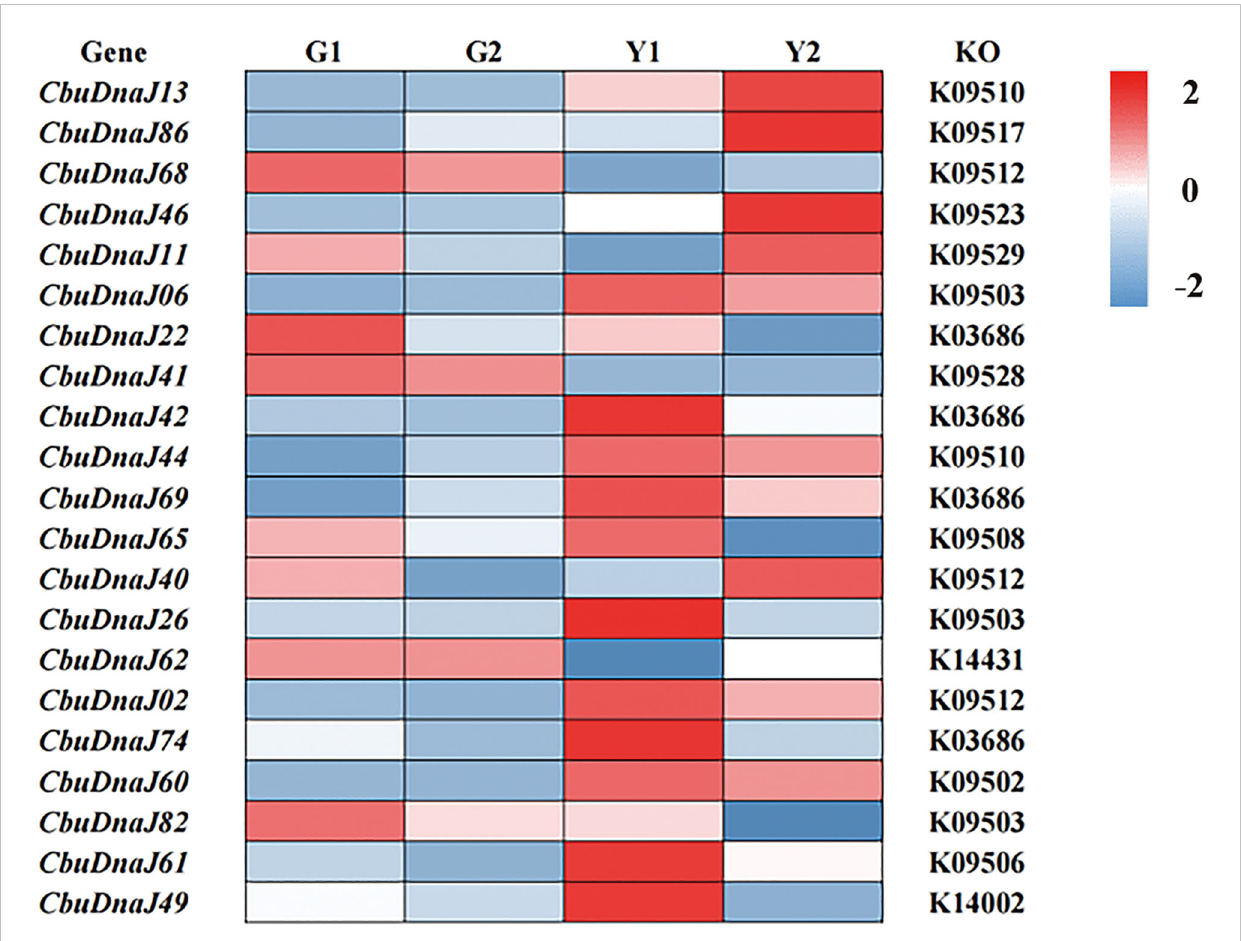
FIGURE 4 The expression pro fi les of CbuDnaJ genes in various leaf color tissues. Red and blue color scale indicates high and low expression levels, respectively.